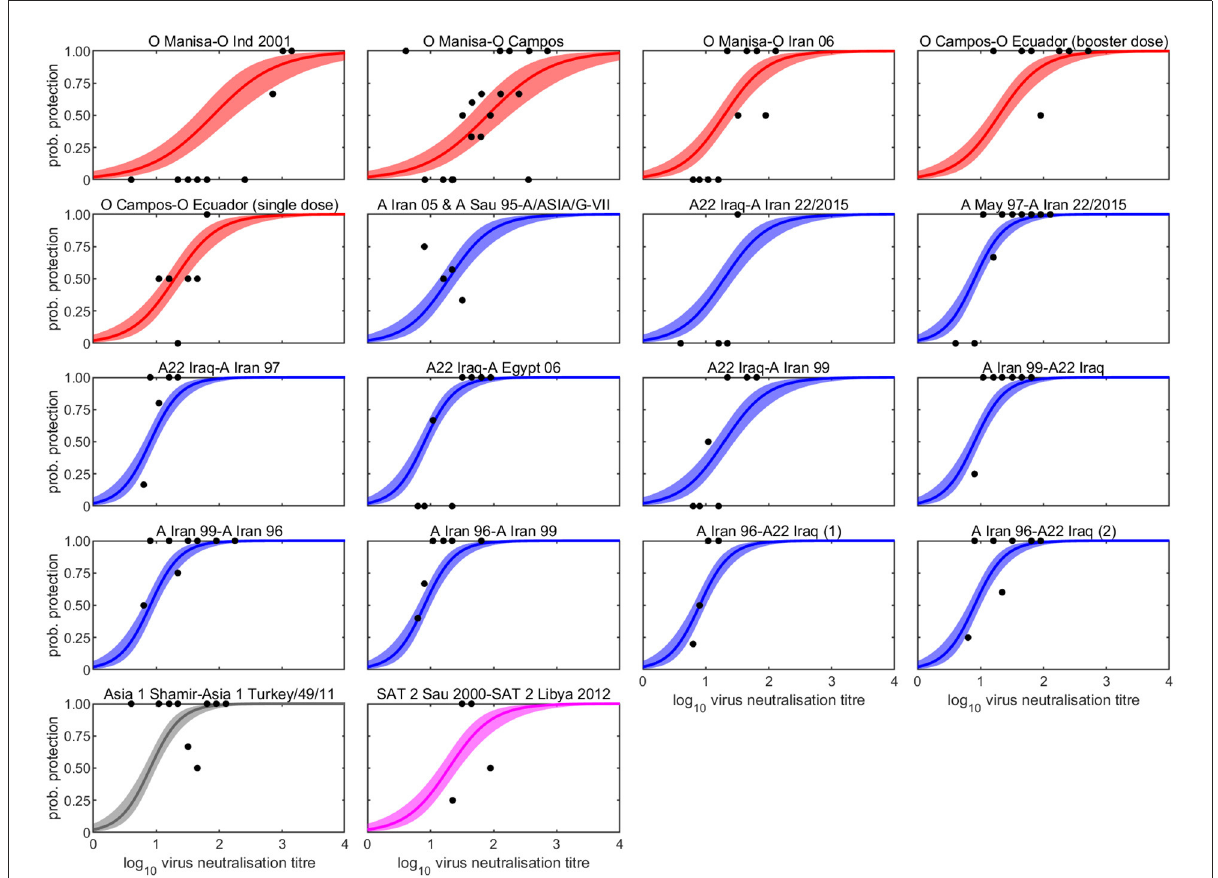
FIGURE1 Observed and estimated probability that a vaccinated bovine animal is protected following heterologous challenge and its dependence on log 10 virus neutralisation titre for eighteen vaccine-challenge studies. The vaccine and challenge strains are identified before and after the hyphen, respectively. Each plot shows the observed proportion of cattle protected at each titre in the study (circles) and the posterior median (line) and 95% credible interval (shading) for the probability of protection. Colour indicates serotype: O (red), A (blue), Asia 1 (grey), and SAT 2 (magenta).